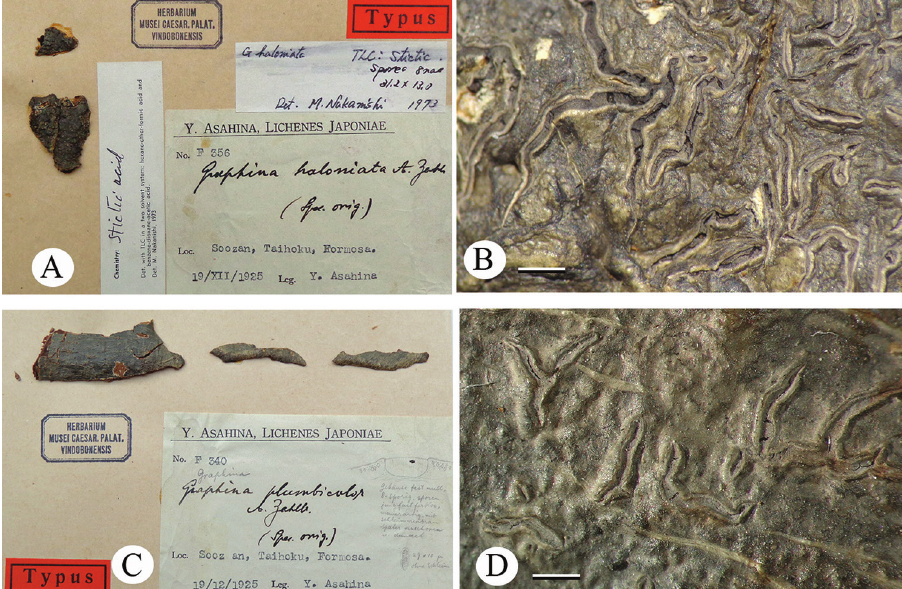
Figuer 2. A, B Type Graphina haloniata ( Asahina 356 ) C, D Type Graphina plumbicolor ( Faurie 83